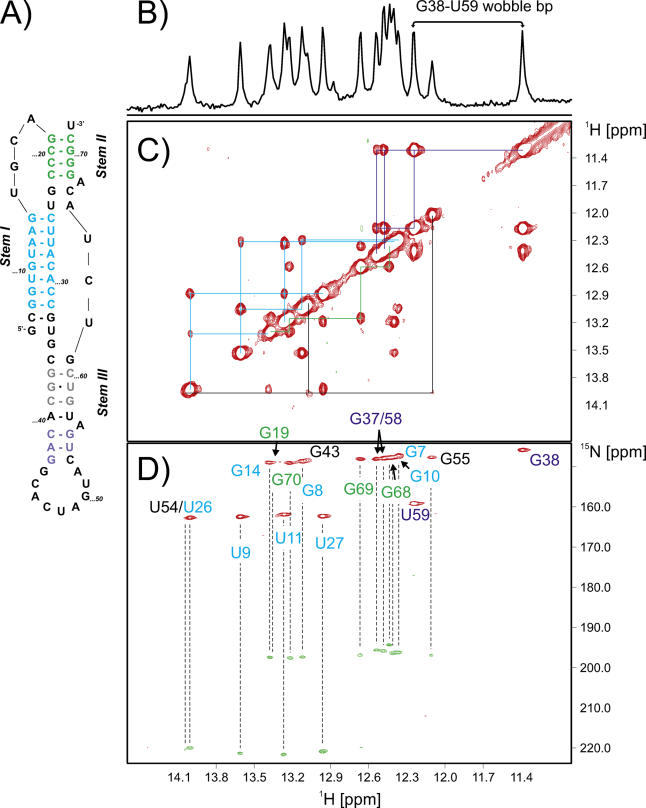
NMR Data Were Collected at 25 °C at a Proton Resonance Frequency of 900 MHz(A) Secondary structure of the SARS-CoV frameshift pseudoknot (residues 13405–13472). Different color coding was used to denote basepaired regions in stems 1 (cyan), 2 (green), and 3 (grey and blue). Only the last two digits of the wild-type sequence numbering are used for clarity.(B) Imino region of a one-dimensional jump-return echo spectrum of SARS-CoV pseudoknot.(C) Portion of a 2D 1H,1H-NOESY. Sequential imino-imino proton NOE assignment paths are shown by different colors for stem 1 (cyan), stem 2 (green), and stem 3 (black and blue).(D) 2D Quantitative J(N,N) HNN-COSY spectrum showing interstrand 1H3–15N3(U) to 15N1(A) and 1H1–15N1(G) to 15N3(C) correlations. Data were collected on a uniformly 13C/15N-labeled sample. Red peaks correspond to diagonal resonances and are labeled with assignment information for the basepaired stem regions matching the color coding in (C). Green cross peaks are caused by scalar cross hydrogen bond 2h
J(N,N) couplings detected using a defocusing delay of 36 ms. Carrier positions were on water for 1H and 185 ppm.